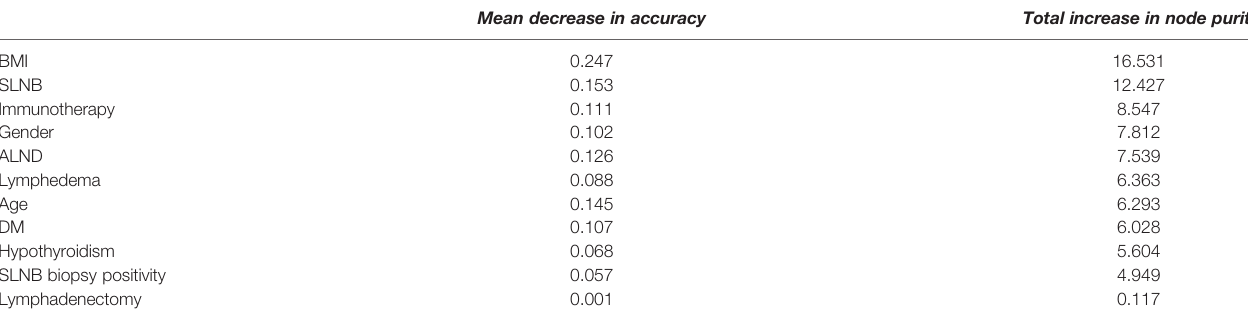
TABLE 4 | Variable importance in patients with trunk